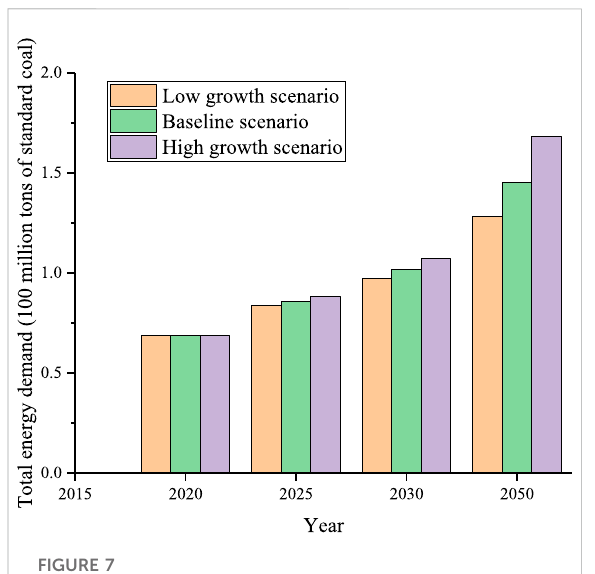
FIGURE 7 Prediction results of total regional rural energy demand.